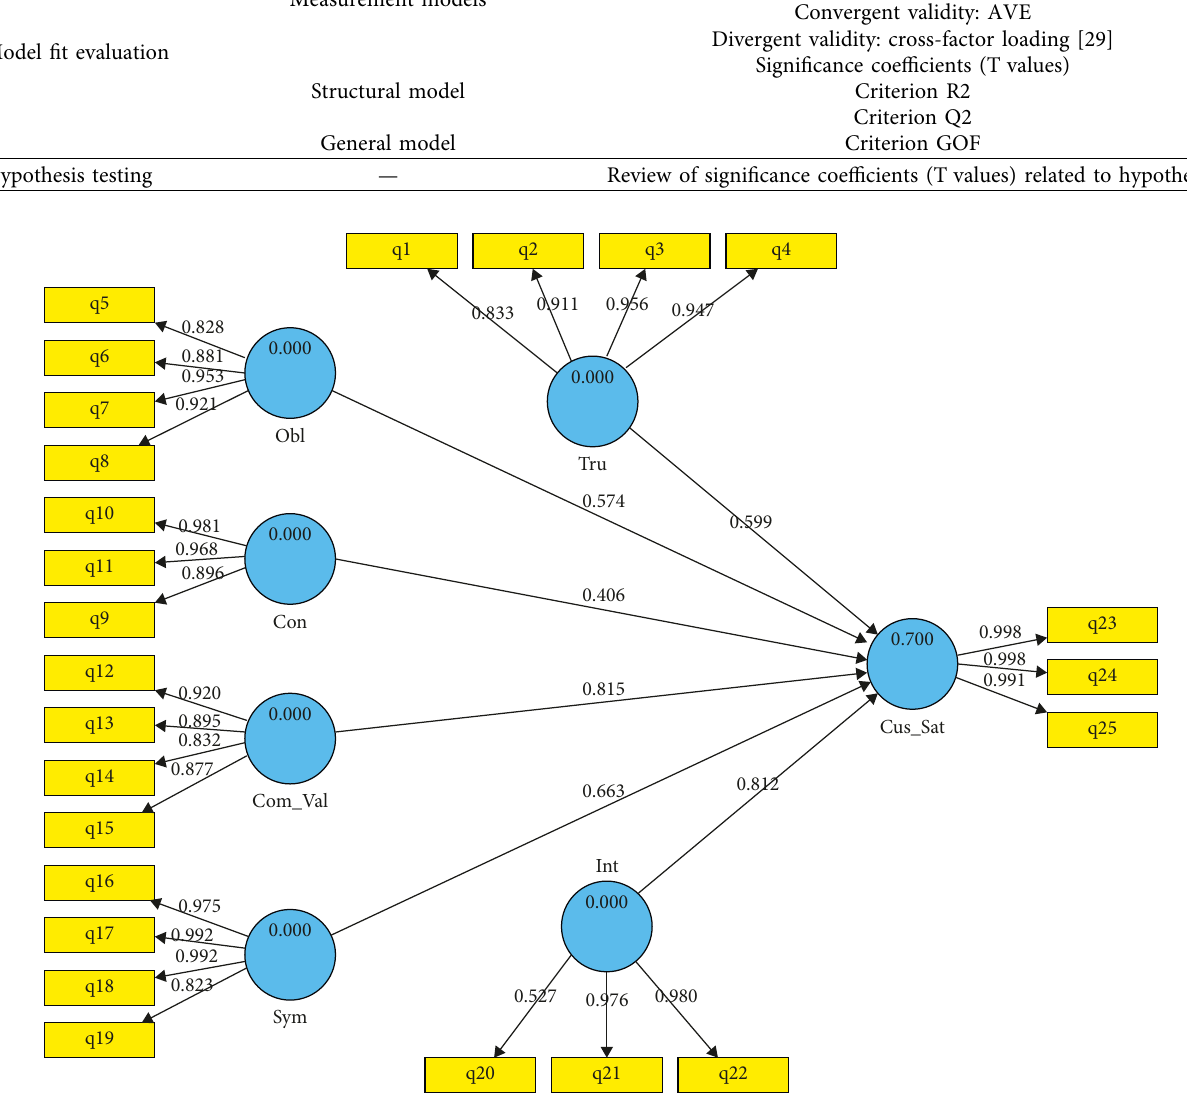
Figure 2: Research structural equation model in standard factor load estimation mode. Table 5: Values of Cronbach’s alpha coefficient, composite reliability, and